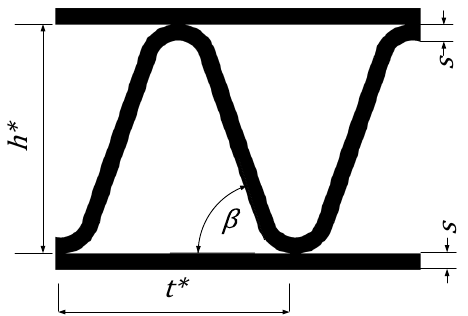
Figure 2. RHX cross-section.